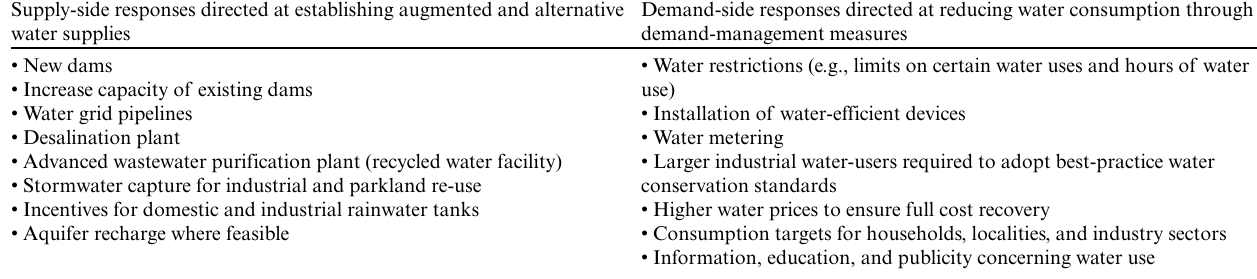
Table 2. Available policy responses to water